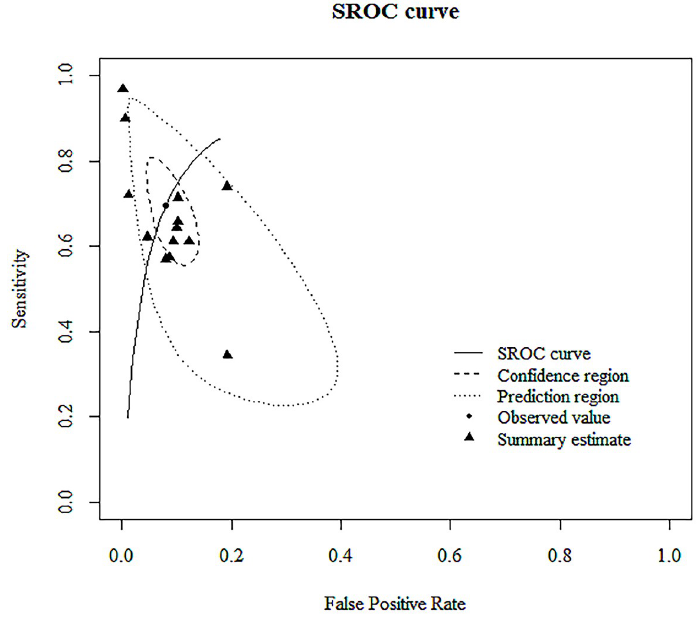
Fig 4. Summary receiver operating characteristic (SROC) curves of the diagnostic accuracy of immunochromatographic tests (ICTs) for Mycoplasma pneumoniae infection. Summary points of the sensitivity and specificity, SROC curve, 95% confidence region, and 95% prediction region are shown. The area under the curve of the SROC curve for ICT was 0.904.